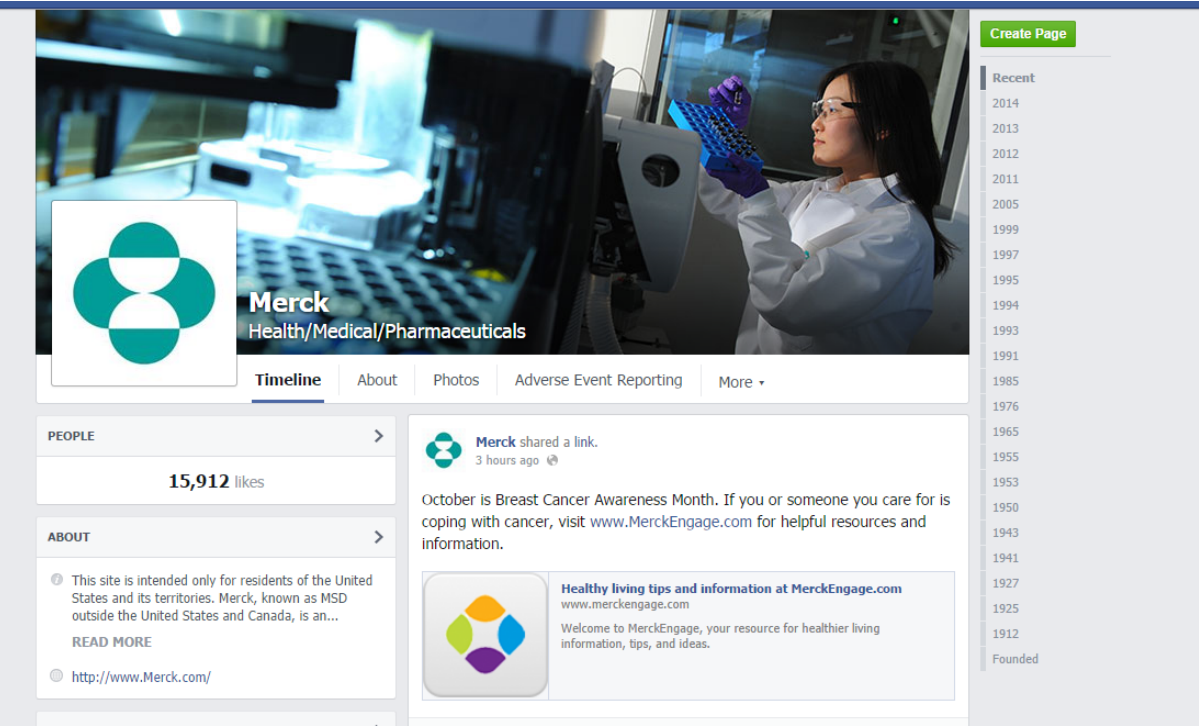
Figure 1. Example Facebook page from company-specific analysis.